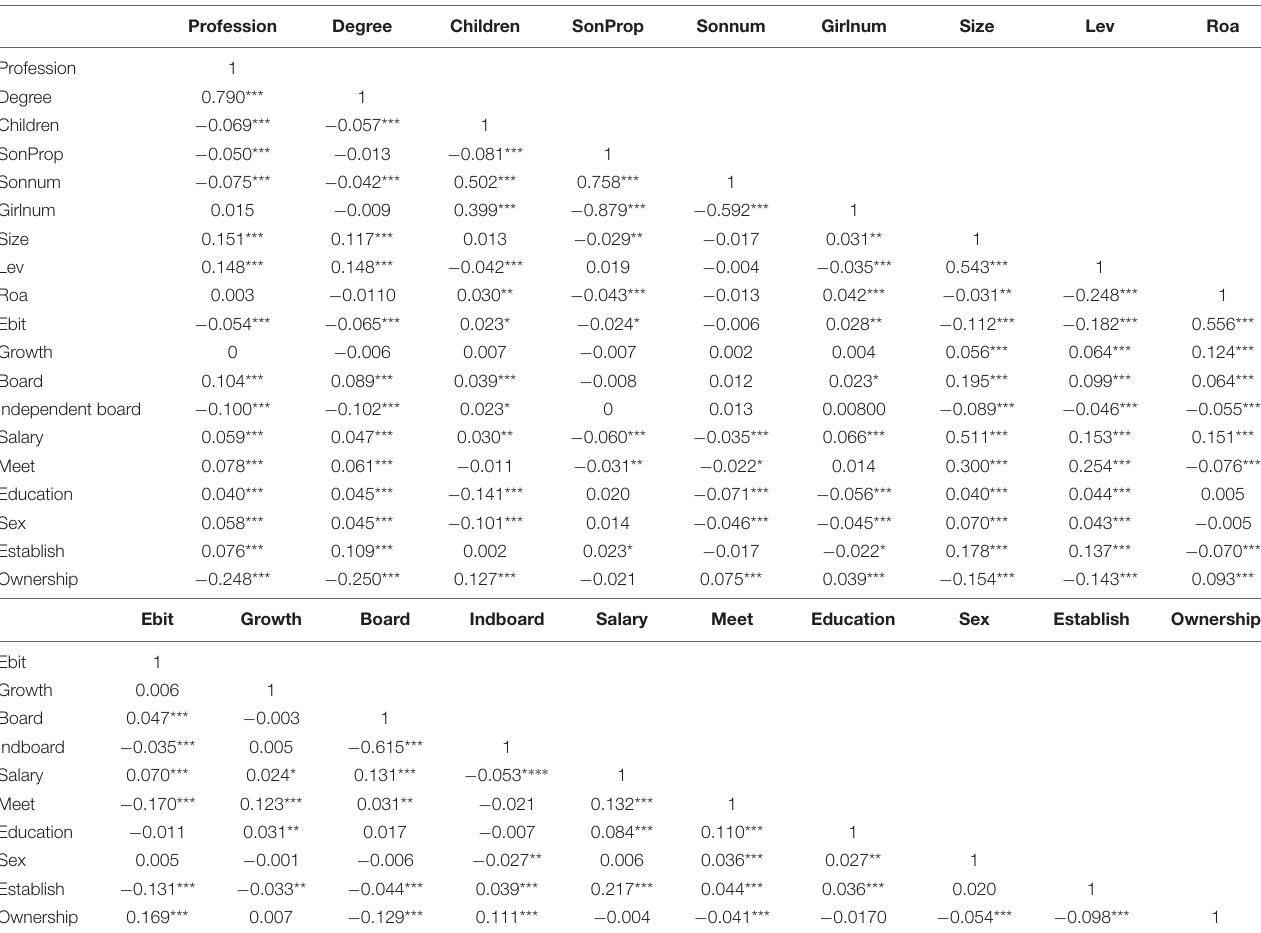
TABLE 3 | Correlation